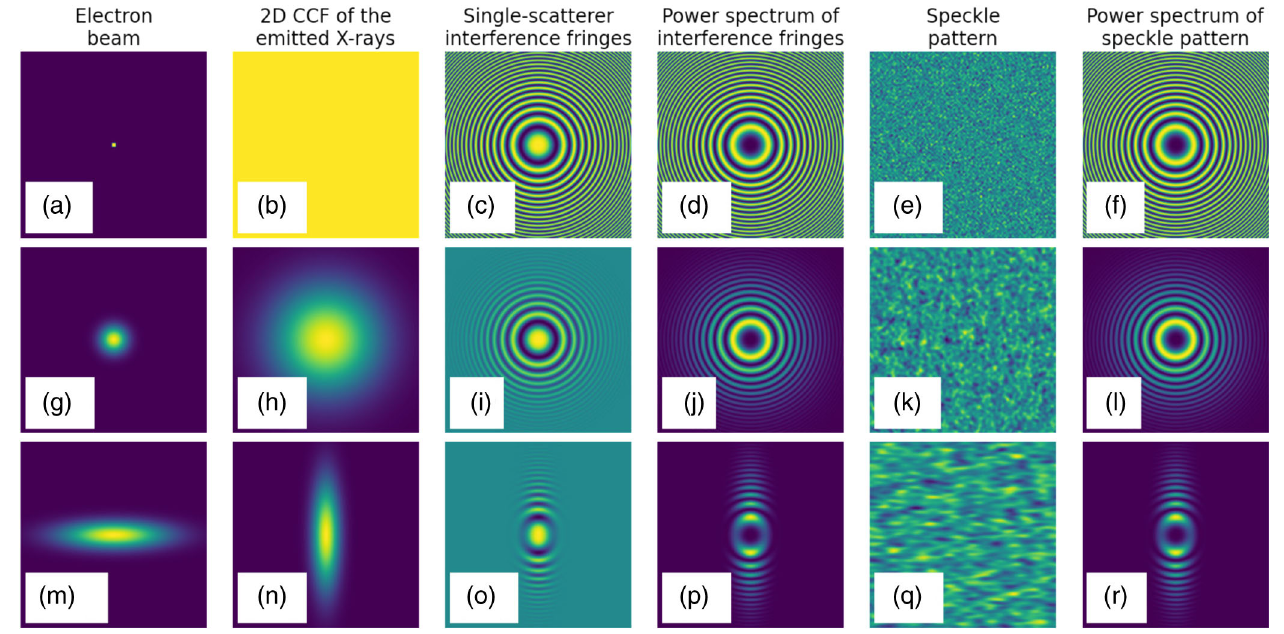
FIG. 4. Summary of the HNFS technique showing the relation between the 2D profile of the electron beam [(a), (g), and (m)], the ⃗ x; z Þ modulus of the 2D CCF μ ð Δ ⃗ x Þ of the emitted synchrotron radiation [(b), (h), and (n)], the single-scatterer interference fringes i ref ð ⃗ q; z Þ [(d), (j), and (p)], the heterodyne speckle pattern i ⃗ x; z Þ generated [(c), (i), and (o)] and the corresponding 2D power spectrum I ref ð het ð by a large number of scatterers [(e), (k), and (q)] and finally the 2D power spectrum of heterodyne speckles I ð ⃗ q; z Þ [(f), (l), and (r)]. The case of a filament electron beam [(a), (b), (c), (d), (e), and (f)], a round electron beam [(g), (h), (i), (j), (k), and (l)] and a horizontally elongated electron beam [(m), (n), (o), (p), (q), and (r)] are depicted. Notice the relation between the 2D transverse profile of the electron beam, the 2D CCF of the emitted synchrotron light and the envelope of the Talbot oscillations in the 2D power